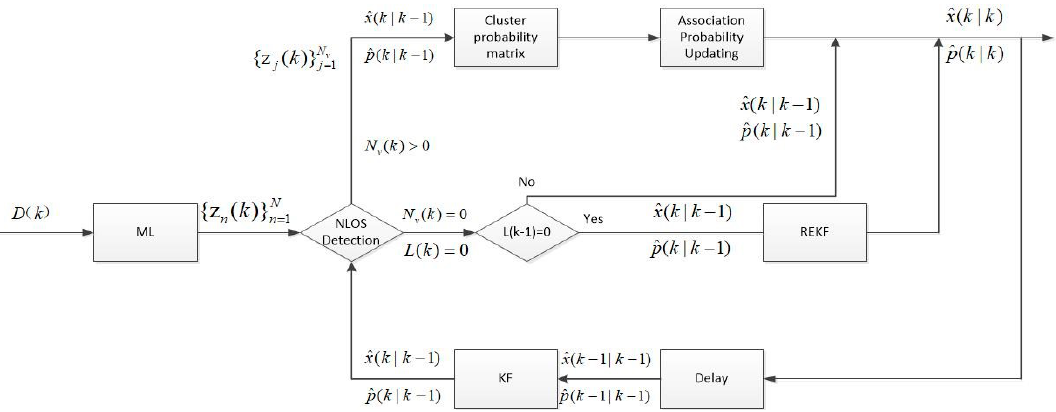
Figure 1. The flow chart of the algorithm.